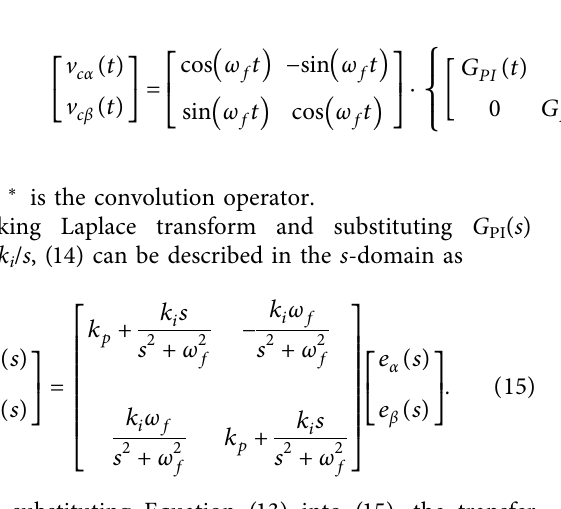
Figure 9: Block diagram of the proposed control